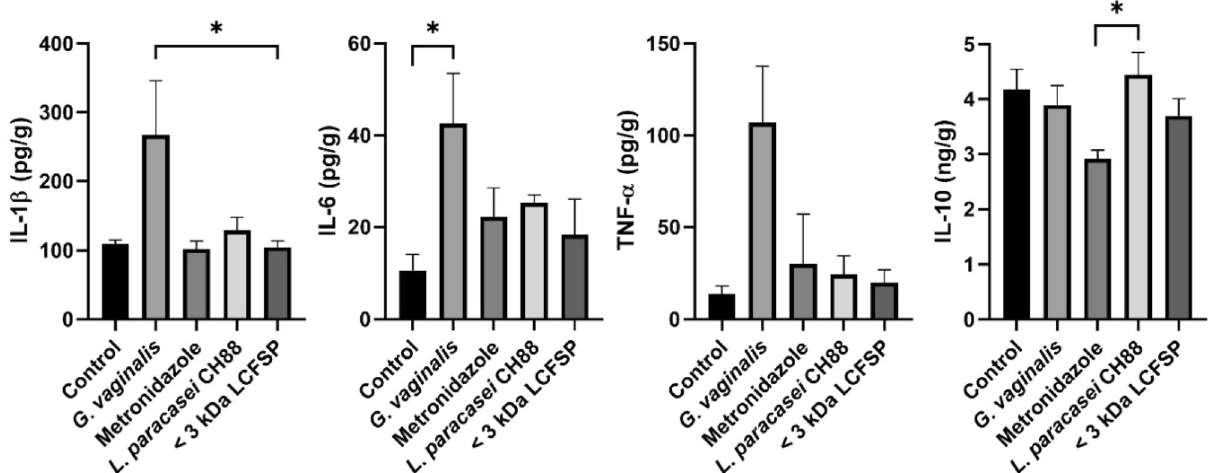
Figure 7. Cytokines in the murine vagina intravaginally treated with phosphate-buffered saline (20 μL), G . vaginalis (1 × 10 8 CFU), metronidazole (100 μg), Lactobacillus paracasei CH88 (1 × 10 10 CFU), and protein fraction below 3 kDa of L. paracasei CH88 cell-free supernatant (20 μg; < 3 kDa LCFSP). Bars are means and standard errors of the means (n = 6) of duplicate experiments. *Significant difference (adjusted p < 0.05; Kruskal– Wallis test with Dunn’s